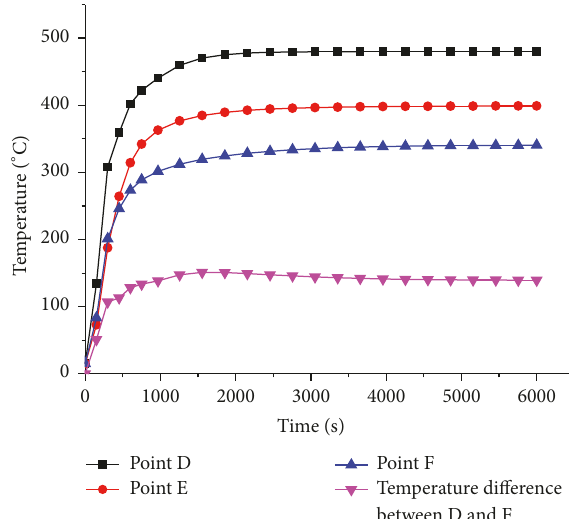
Figure 10: Temperature variation of monitored locations on the 1st turbine disc during start-up